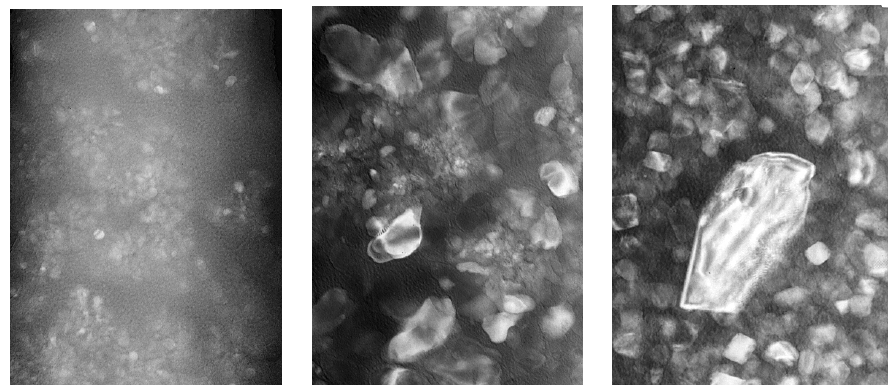
Figure 10: Development of crystallization and increasing crystal size with increasing heating temperature in basalt fibers after heating to 720°C (a), 820°C (b) and 1020°C (c) as seen in Transmission Electron Microscopy [12]. Two kinds of crystals are clearly distinguished in (b) and (c), namely, large spinels and small pyroxenes. Panel widths: 0.5